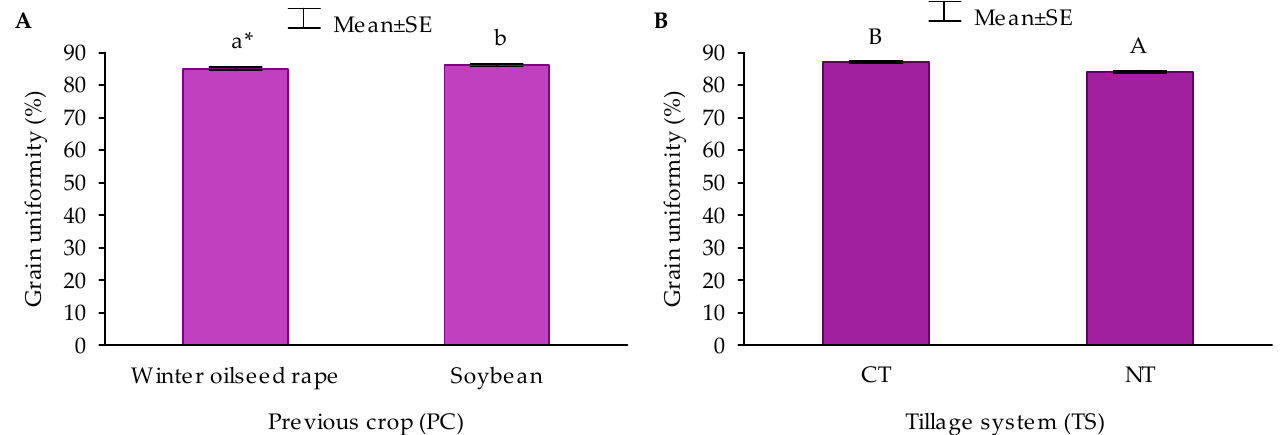
Figure 10. Uniformity of winter wheat grain depending on previous crop and tillage system (mean for 2014–2017). CT— Conventional tillage; NT—No-tillage. * Different letters denote significant differences ( p ≤ 0.05). The lowercase letters refer to previous crops (PC); the capital letters refer to tillage systems (TS).